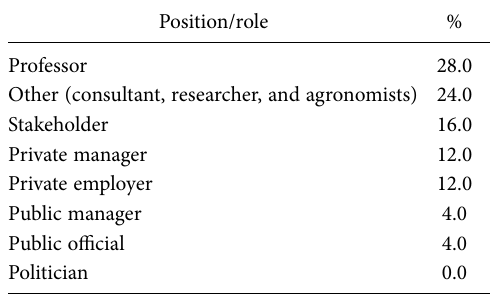
Table 4. Characteristics of respondents: position/role